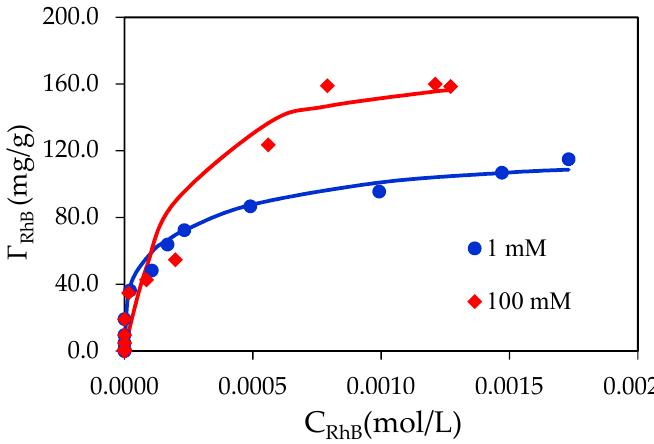
Figure 10. Adsorption isotherms of RhB onto SDS modified nano γ -Al 2 O 3 (SMNA) at different NaCl concentrations. The points are experimental data while solid lines are fitted by a two-step adsorption model.